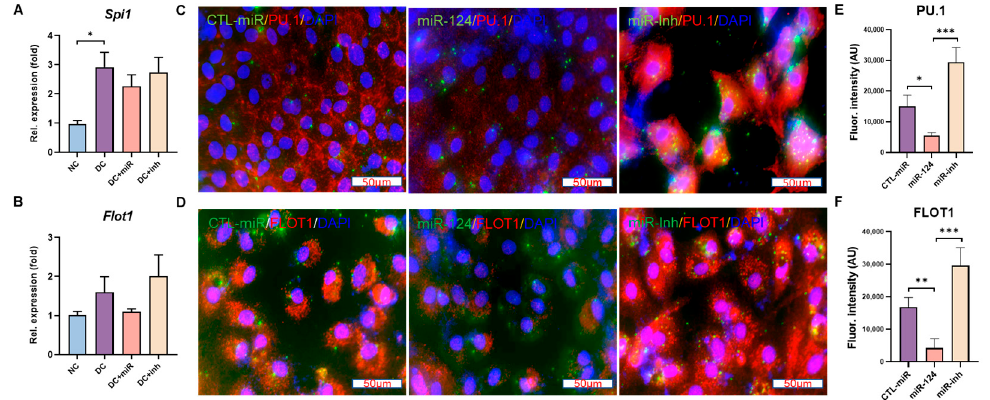
Figure 7. Downregulation of PU.1 and Flot1 by miR-124. ( A , B ) The relative expression of gene Spi1 ( A ) and Flot1 ( B ) in the rat retinae of non-diabetic controls (NC), diabetic controls (DC), DC treated with miR-124 (DC+miR) or its inhibitor (DC+inh) measured by quantitative RT-PCR. ( C , D ) Im- munocytochemistry (ICC) of PU.1 ( C ) and FLOT1 ( D ) in primary rat microglial cells transfected with control miRNA (CTL-miR), miR-124 mimic (miR-124), or miR-124 inhibitor (miR-inh). PU.1 and FLOT1 were detected using Alexa Fluor 555 labeled secondary antibody (red), miRNA localization was visualized by FITC (green) due to its fluorescein-labeled form, and cell nuclei were labeled with DRAQ5 TM (blue). Images were taken with the Leica confocal microscope SP8, scale bar = 50 µ m. ( E , F ) Quantification of ICC immunofluorescence of PU.1 ( E ) and FLOT1 ( F ) using Image J/Fiji soft- ware. Data are exhibited as mean ± SD, n = 5, * p < 0.05, ** p < 0.01, *** p < 0.001 (one-way ANOVA with Tukey’s multiple comparisons